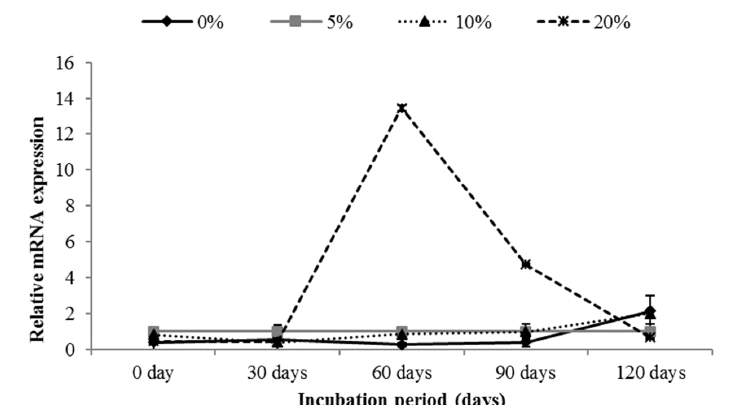
Figure 6. mRNA expression profile of nif H gene in Psuedomonas mendocina S10 inoculated in soil treated with moisture percentage 0%, 5%, 10%, and 20% Each data point represents mRNA abundance of nif H gene normalized to 16S rRNA, which was used as a housekeeping gene. One-way ANOVA determined the significance of difference. Each data point represents mean and the vertical line on it indicates the standard error. The asterisk shows significance level: p<0.05 with 0-day